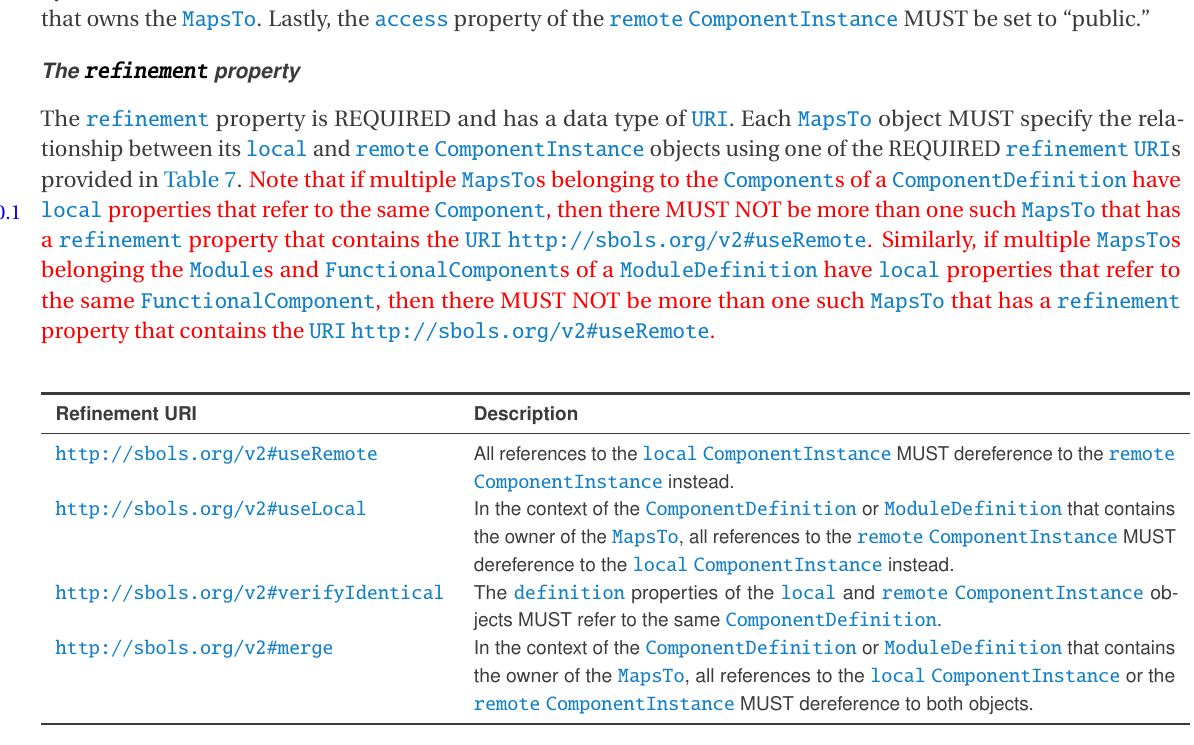
Table 7: REQUIRED URI s for the refinement